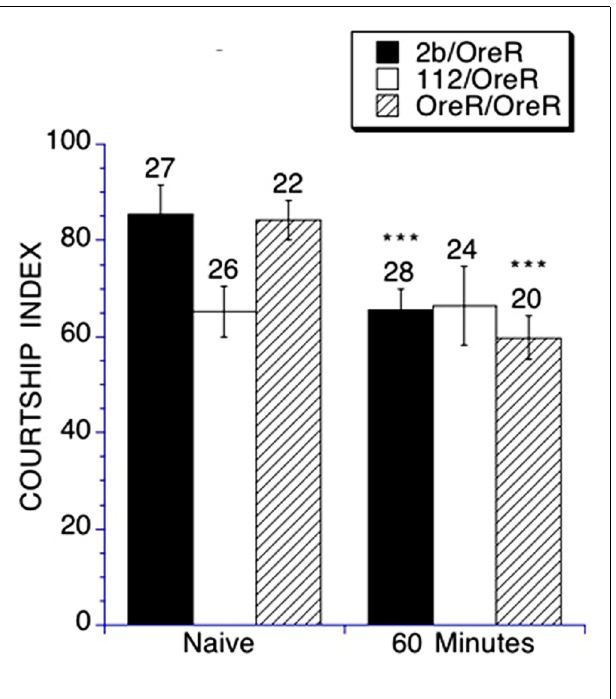
FIGURE 4 |The short-term memory of conditioned courtship is impaired in heterozygous DmGluRA 112 mutant flies. Short-term memory was measured by placing a trained male in a holding chamber for 60 min, then subsequently placing him in a testing chamber with a virgin female target for a 10 min courtship interval.The resulting CI is compared to the CI obtained for naïve courtship. Mean CIs ( ± SEM) are plotted; Ns are indicated above each bar for all groups. For levels of significance, *** p < 0.001. Control DmGluRA 2b flies (filled black bars) and control OreR background flies (striped bars) exhibited intact short-term memory as demonstrated by a significant depression of courtship activity in the trained versus the naïve groups.The DmGluRA 112 mutant flies (open bars) did not demonstrate a suppression of courtship activity after training and therefore had impaired short-term memory.